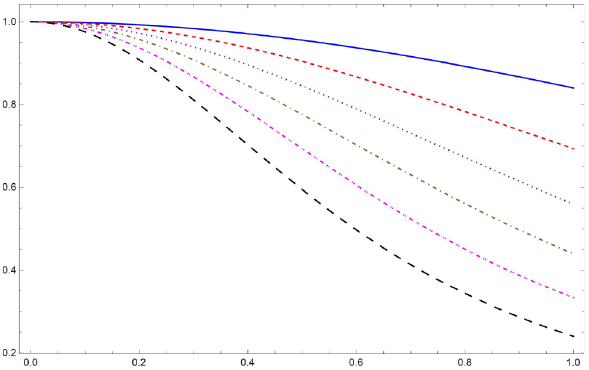
Fig. 2 ˜ ρ/ ˜ ρ c vs x for of y = 0 . 05 solid (blue) curve, y = 0 . 10 dashed (red) curve, y = 0 . 15 dotted (purple) curve, y = 0 . 20 dot-dashed (brown) curve, y = 0 . 25 doubled dot-dashed (magenta) and y = 0 . 30 long dashed (black) curve in the first case, taking as seed the FS solution and with the same original complexity factor